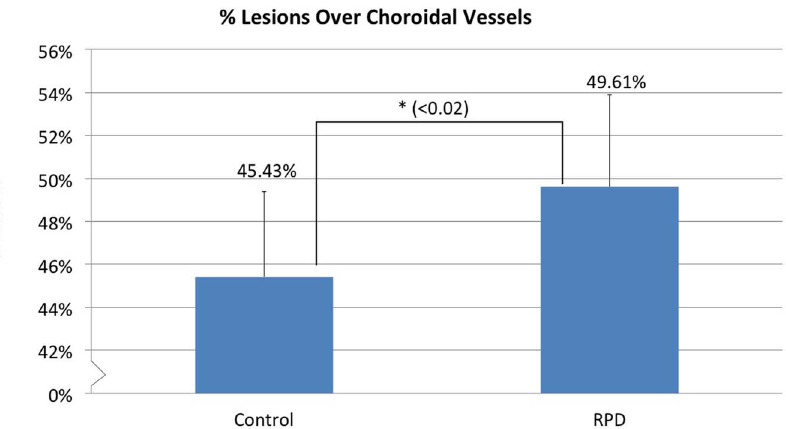
Figure 4. Percentage of RPD and Control RPD lesions (randomly placed dots) overlying the choroidal vasculature. An average of 49.6 6 4.3% of RPD lesions were overlying the choroidal vasculature which was significantly higher than the 45.4 6 3.9% of control lesions. (p=0.014).